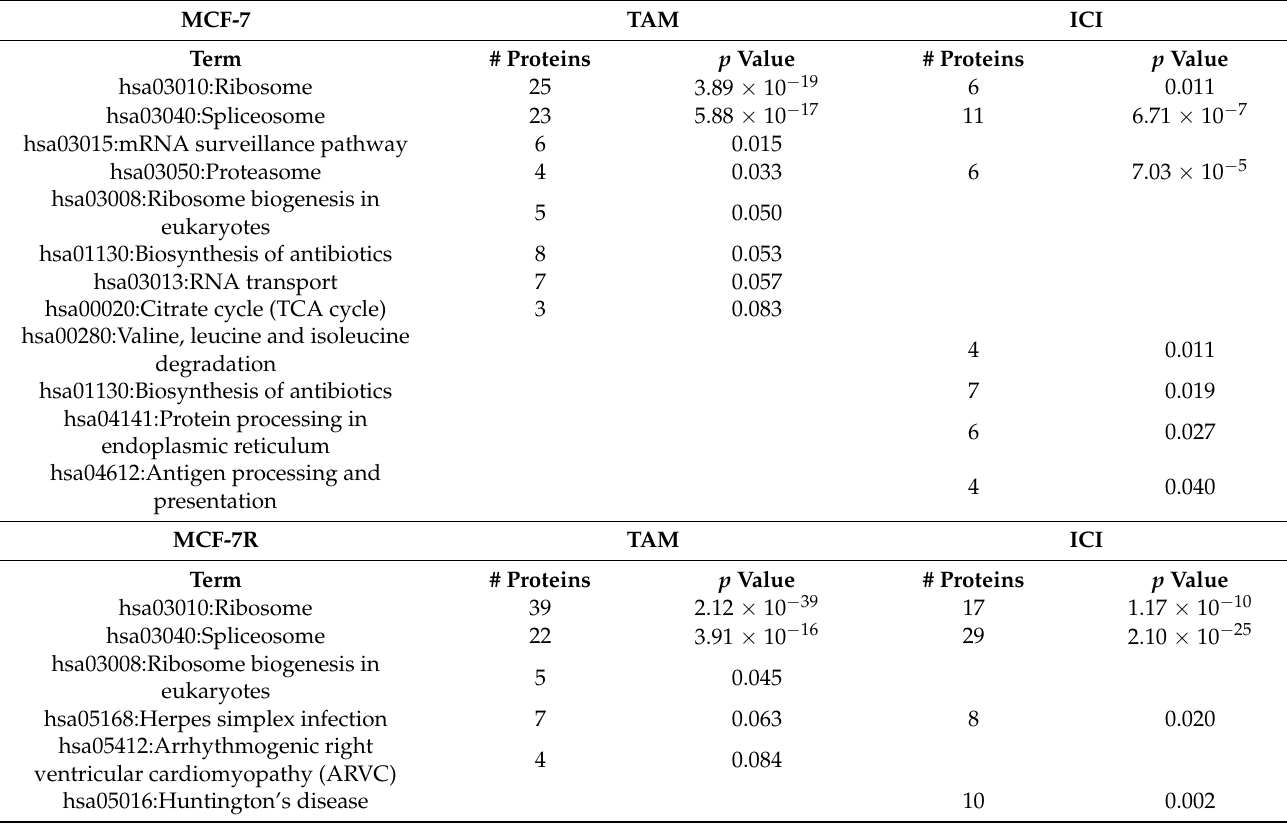
Table 2. Kegg pathways represented by the aggregated proteins uniquely identified as upregulated in MCF-7 and MCF-7R cell lines after 24 h treatment with 250 nM ICI or 500 nM